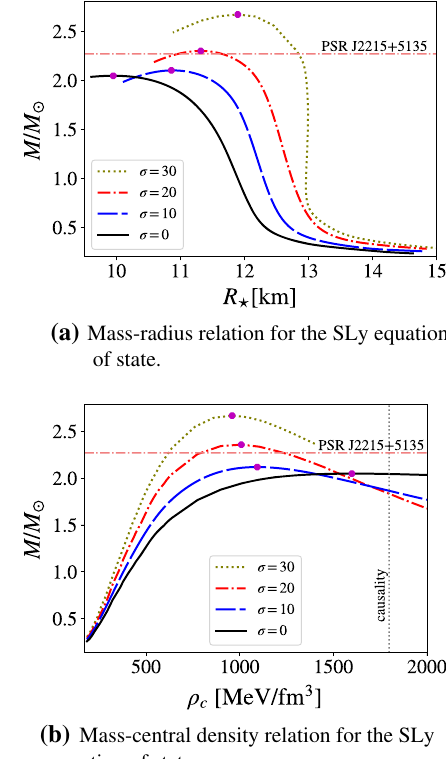
Fig. 3 Mass-radius ( a ) and mass-central density ( b ) relations for sev- eral values of σ and for the SLy4 EoS. The magenta circles mark the maximummassoneachcurve.Inbothpanelsahorizontaldashed-dotted line indicates the PSR J2215 + 5135 mass. In panel b vertical dotted line represents the causality